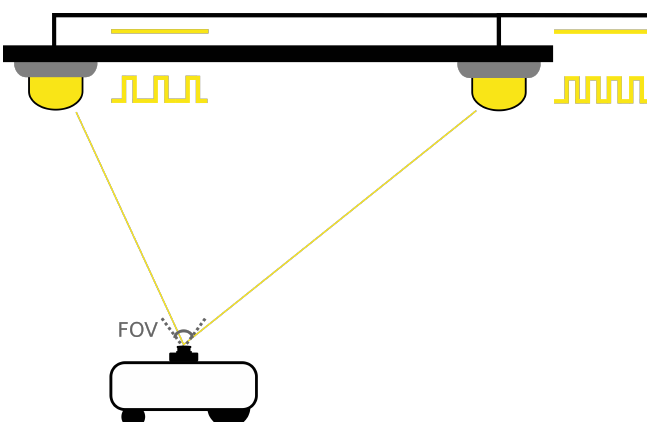
Figure 1. Model of the proposed Visible Light Positioning (VLP)